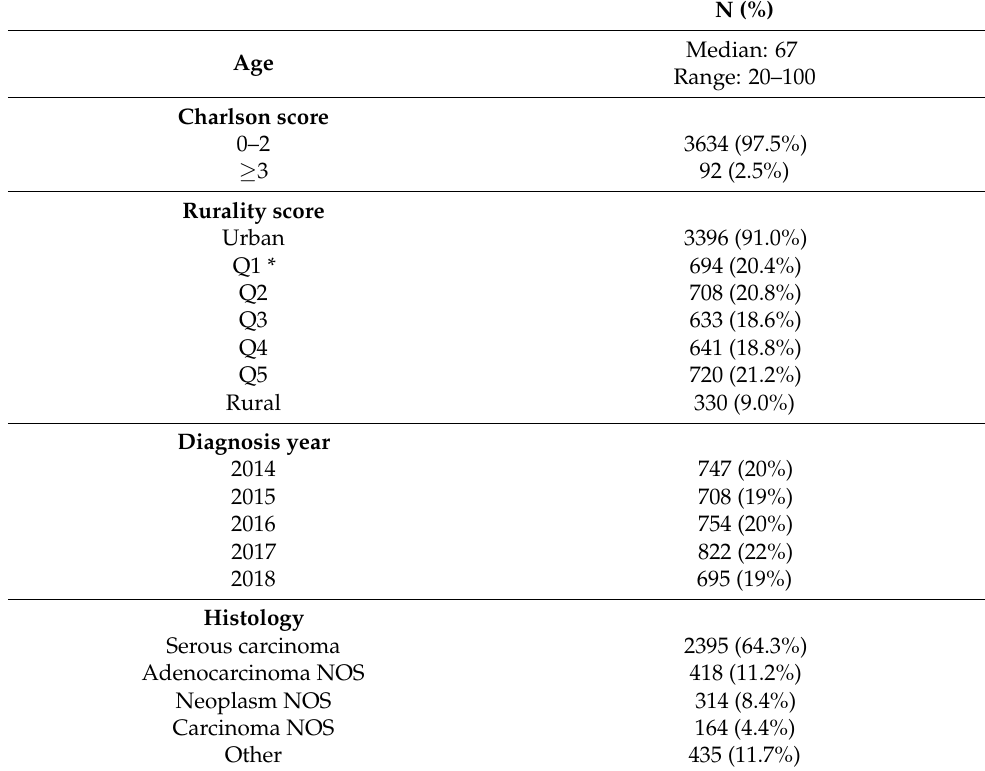
Table 1. Baseline characteristics of patients with advanced